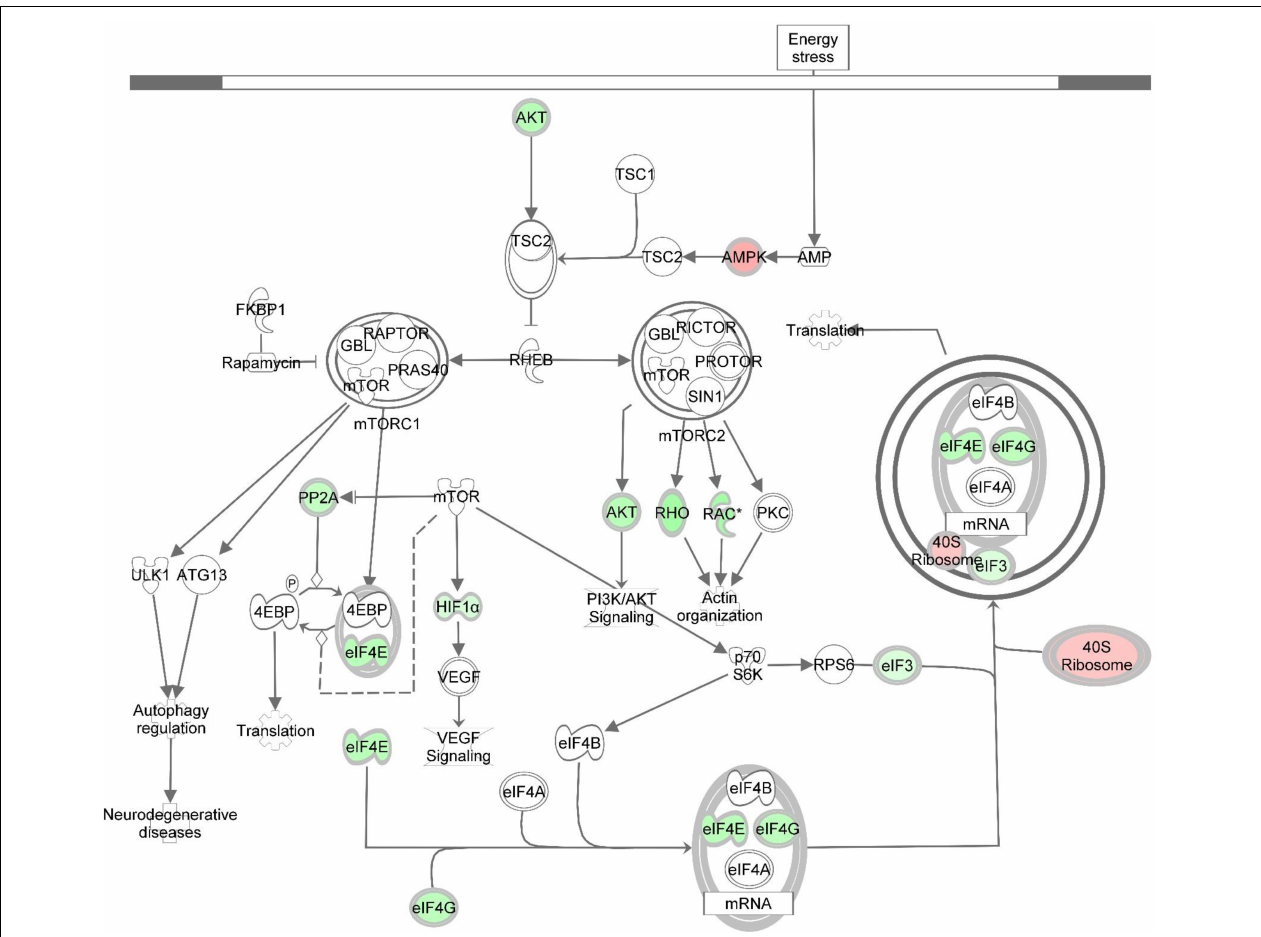
FIGURE 5 | Knockdown of DAP alters gene expression of the mTOR signaling pathway during proliferation of turkey satellite cells. Intermolecular connections between genes are as defined by IPA analysis. *FDR < 0.05. 4EBP, 4E binding protein; ATG13, autophagy related 13; eIF3, eukaryotic translation initiation factor 3; eIF4A, eukaryotic translation initiation factor 4A; eIF4B, eukaryotic translation initiation factor 4B; eIF4G, eukaryotic translation initiation factor 4G; FKBP1, FK506 binding protein 1A; GBL, G protein beta subunit like; HIF1 α = hypoxia inducible factor 1 alpha subunit; mTOR, mechanistic target of rapamycin; mTORC1, mechanistic target of rapamycin complex 1; mTORC2, mechanistic target of rapamycin complex 2; p70S6K, p70S6 kinase; PI3K, phosphoinositide 3-kinase; PKC, protein kinase C; PP2A, protein phosphatase 2; catalytic subunit, alpha isozyme; PRAS40, proline-rich Akt substrate 40; RAC, Ras-related C3 botulinum toxin substrate; Rheb, Ras homolog enriched in brain; Rho, Rhodopsin; RPS6, ribosomal protein S6; TSC1, tuberous sclerosis protein 1; TSC2, tuberous sclerosis protein 2; VEGF, vascular endothelial growth factor. Red highlighting indicates up-regulated genes; green highlighting indicates down-regulated genes. This pathway was generated through the use of Ingenuitay Pathway Analysis (QIAGEN, Inc. https://digitalinsights.qiagen.com/products-overview/discovery-insights-portfolio/